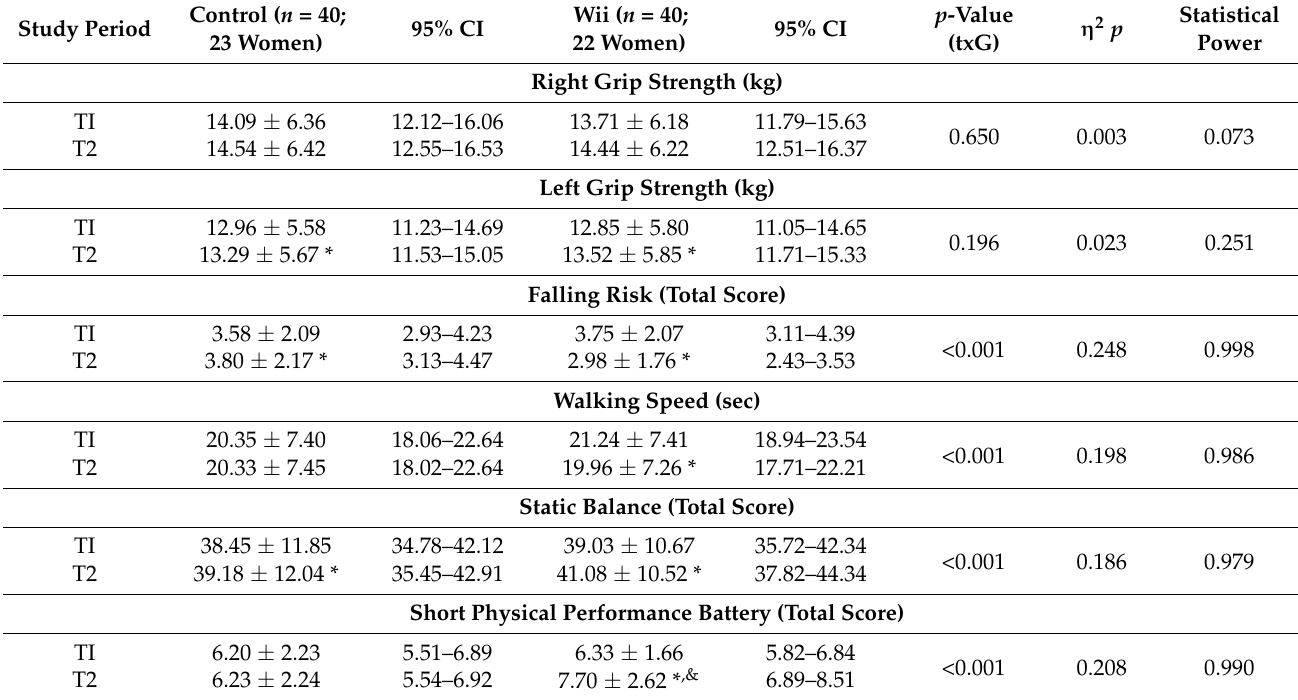
Table 3. Statistical analysis of physical and functional tests.